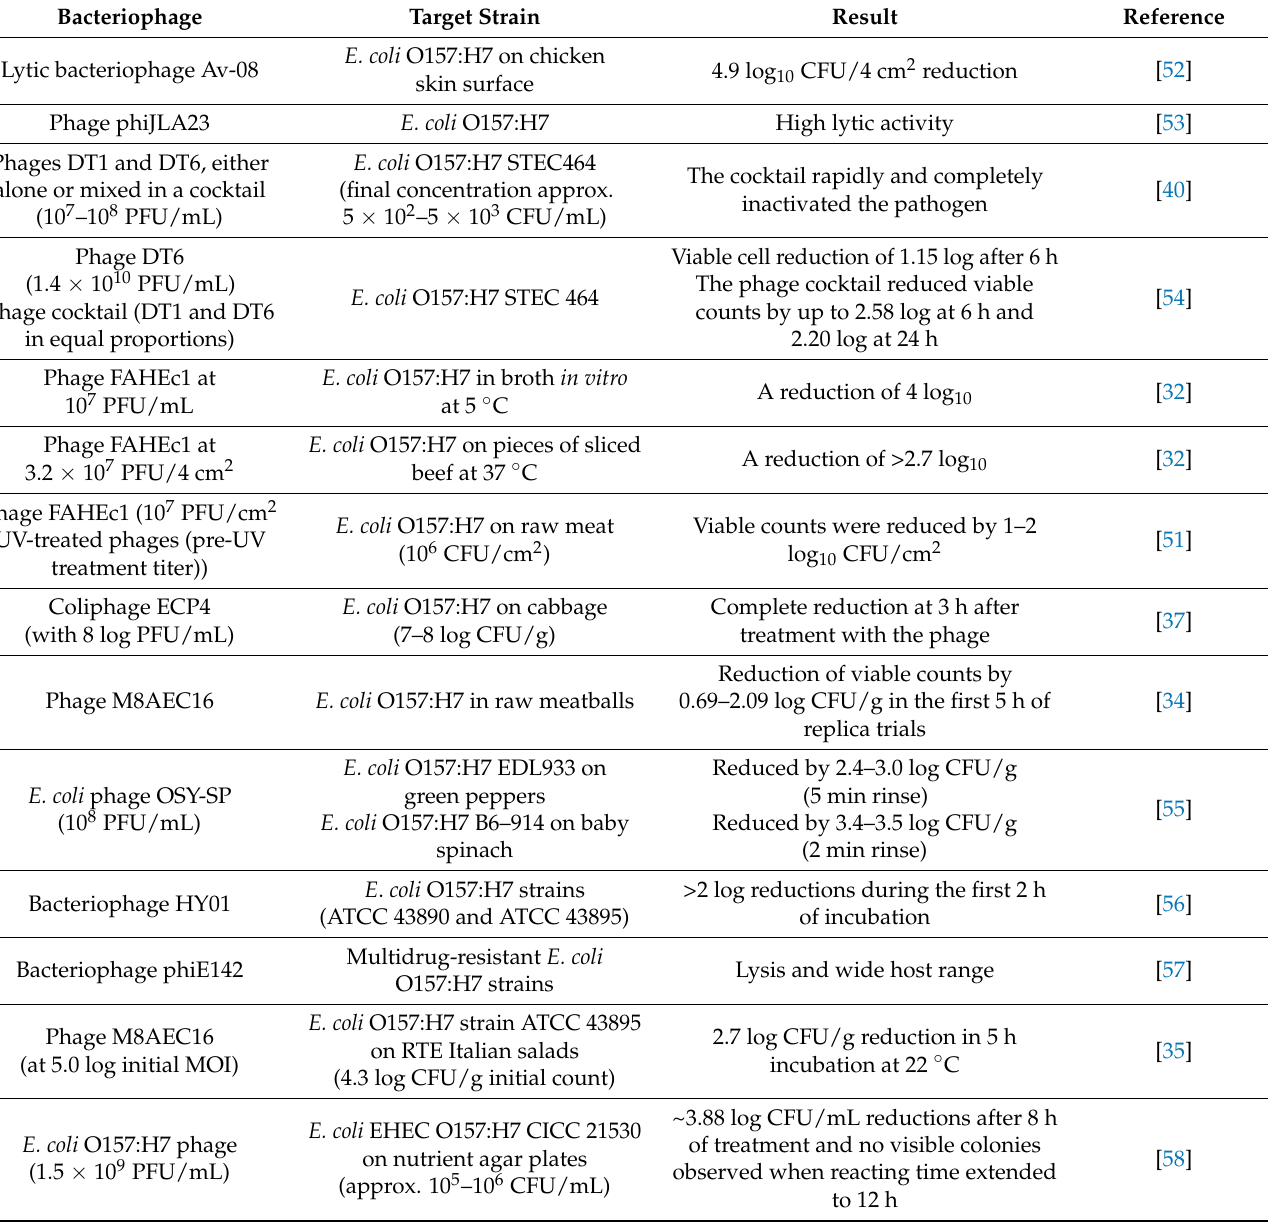
Table 1. List of some studies that reported successful application of phages for E. coli O157:H7 control in